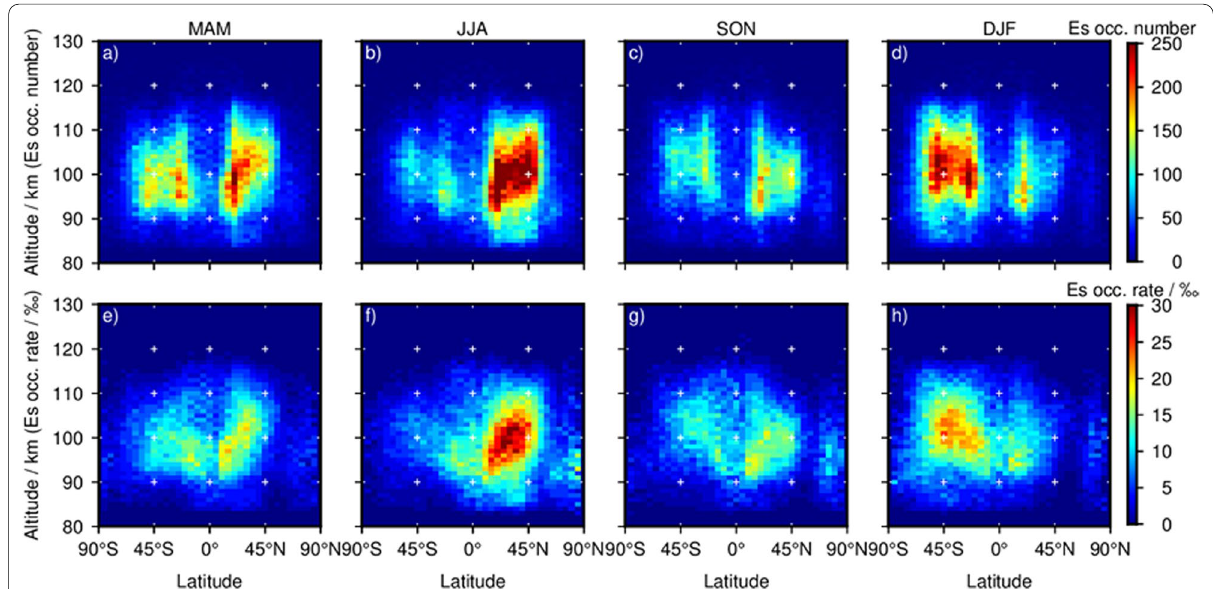
Fig. 11 Seasonal variation in the altitude–latitude distributions of COSMIC RO-derived Es occurrence numbers (upper panels) and occurrence rates (lower panels) during Jan. 2015 to Dec.